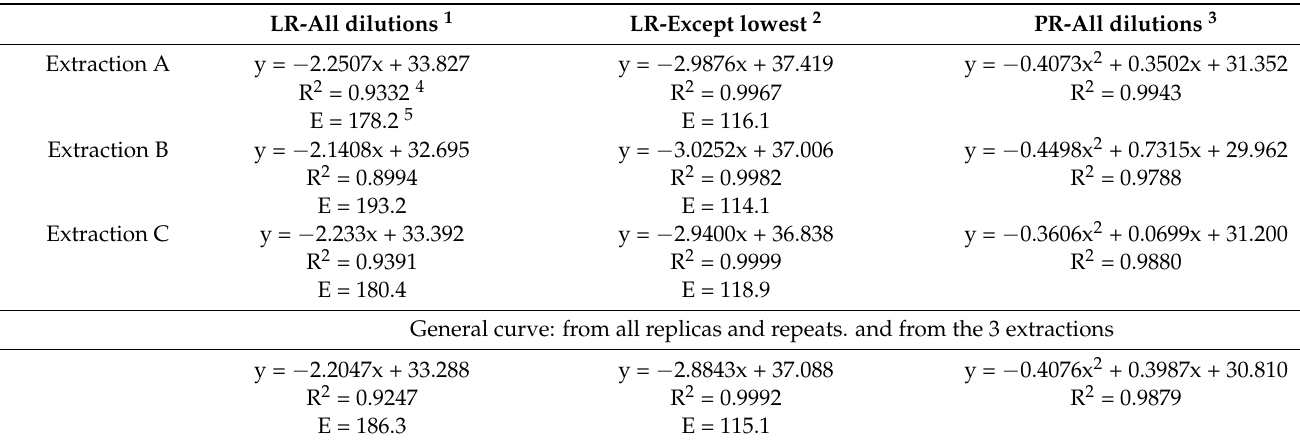
Table 7. Reliability of the quantification of viruses from infected fish tissues: Assay